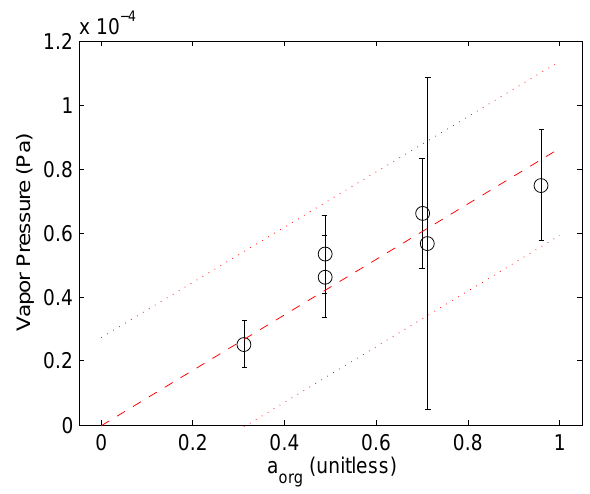
Fig. 1. Measured vapor pressure p L of 2-methylglutaric acid (cir- cles) as a function of the mole fraction based organic activity a org at 280.5K. The value of the (dashed) fit line intercept at a org = 1 rep- resents the pure component liquid vapor pressure at 280.5K and 2 σ error bounds are shown by dotted lines. The fit line is made through the origin and data are weighted by the square of their inverse rela- tive error. For the calculation of error bounds and a more complete description of the error analysis, see Appendix